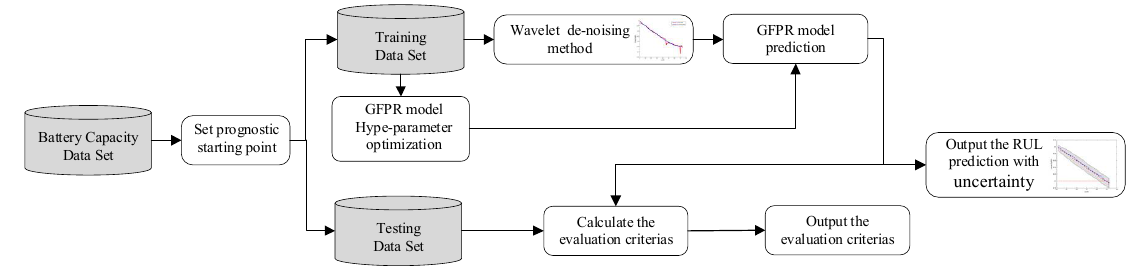
Figure 1. The proposed hybrid method with WD method and HGPFR model.